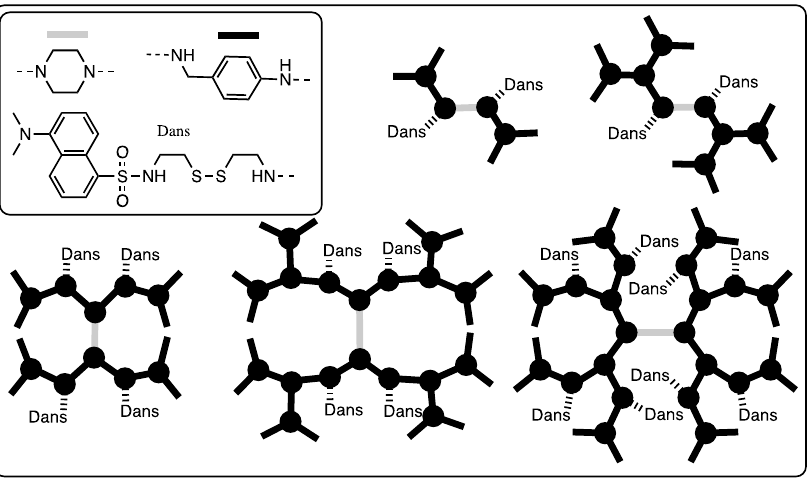
Chart 4. Bowtie dendrimers shown schematically with dansyl groups. Cooperative release was not